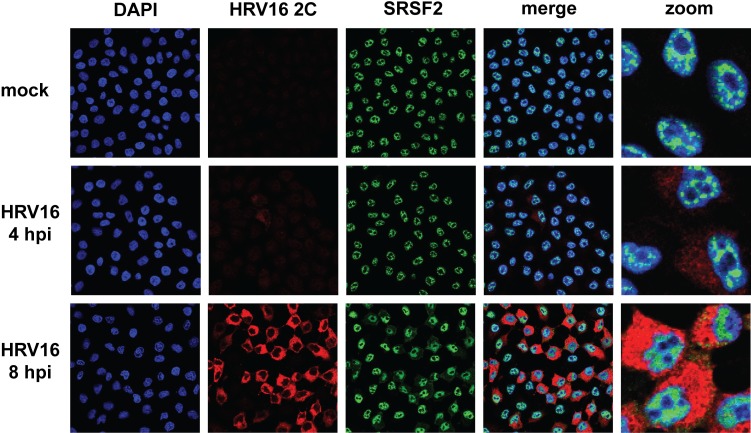
Serine and arginine rich splicing factor 2 (SRSF2) remains within the nucleus of HRV16-infected HeLa cells.HeLa cells were mock- or HRV16-infected (MOI 10) then fixed on coverslips at the indicated times post-infection. HRV16 2C (red) and SRSF2 (green) were labeled by indirect immunofluorescence. DNA was counterstained with DAPI to indicate the location of nuclei (blue). Cells were imaged using confocal microscopy. Hpi: hours post infection.